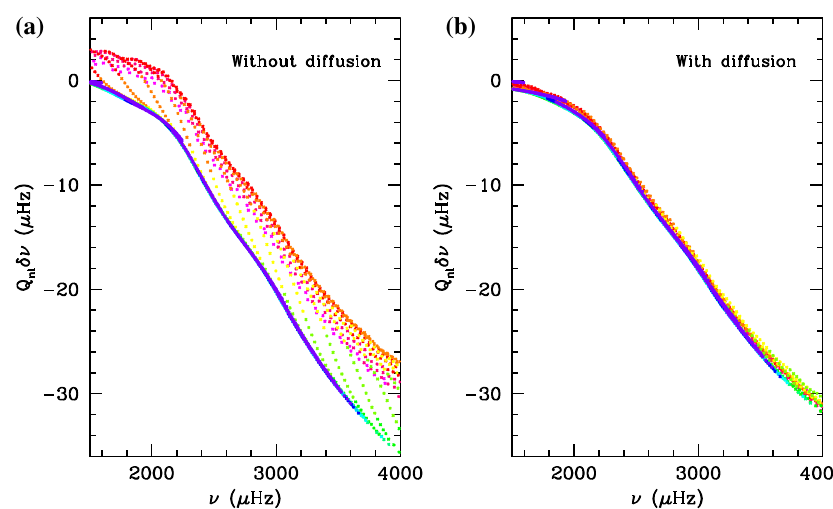
Fig. 5 The scaled frequencies differences between the Sun and two standard models, one without diffusion ( a ) and one with ( b ). The BiSON-13 mode set (Basu et al. 2009) is used for the Sun. The two models are models NODIF and STD of Basu et al. (2000a). Colours are the same as in Fig.